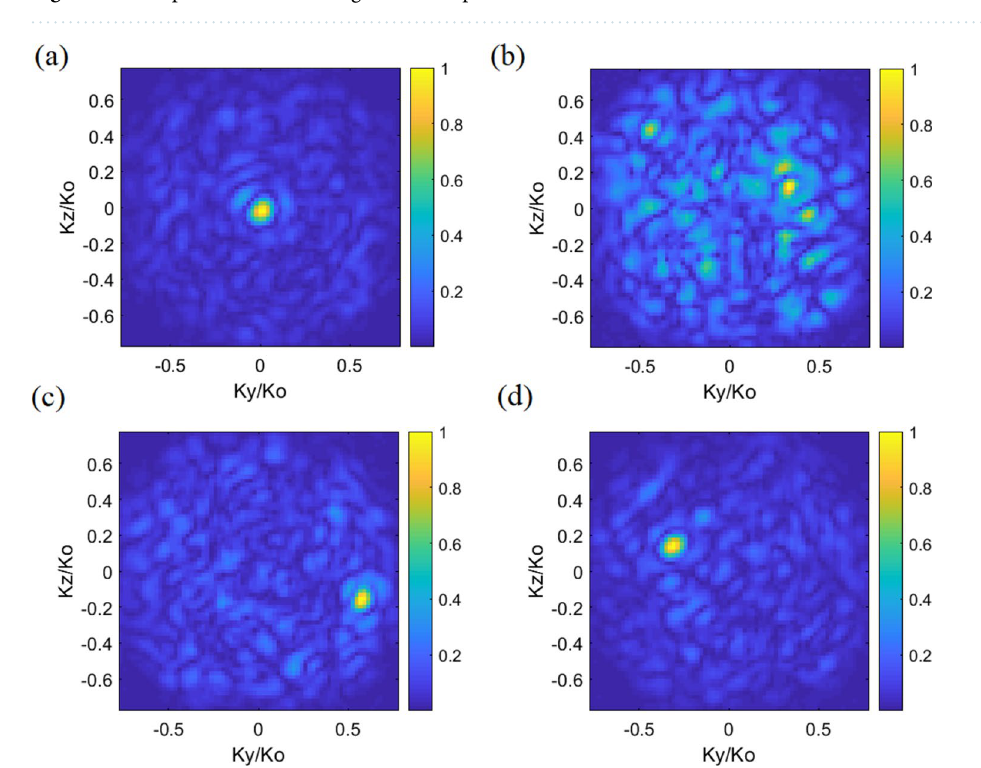
Figure 9. DoA estimation using near-field measured results of 41 modes from 27.0 to 29.0 GHz when a plane wave at 28 GHz strikes the lens-loaded cavity: ( a ) Case 1: ( θ = 0°, φ = 0°), ( b ) Case 2: ( θ = 20°, φ = 20°), ( c ) Case 3: ( θ = 35°, φ = − 15°), and ( d ) Case 4: ( θ = 20°, φ = − 20°) at SNR = 20